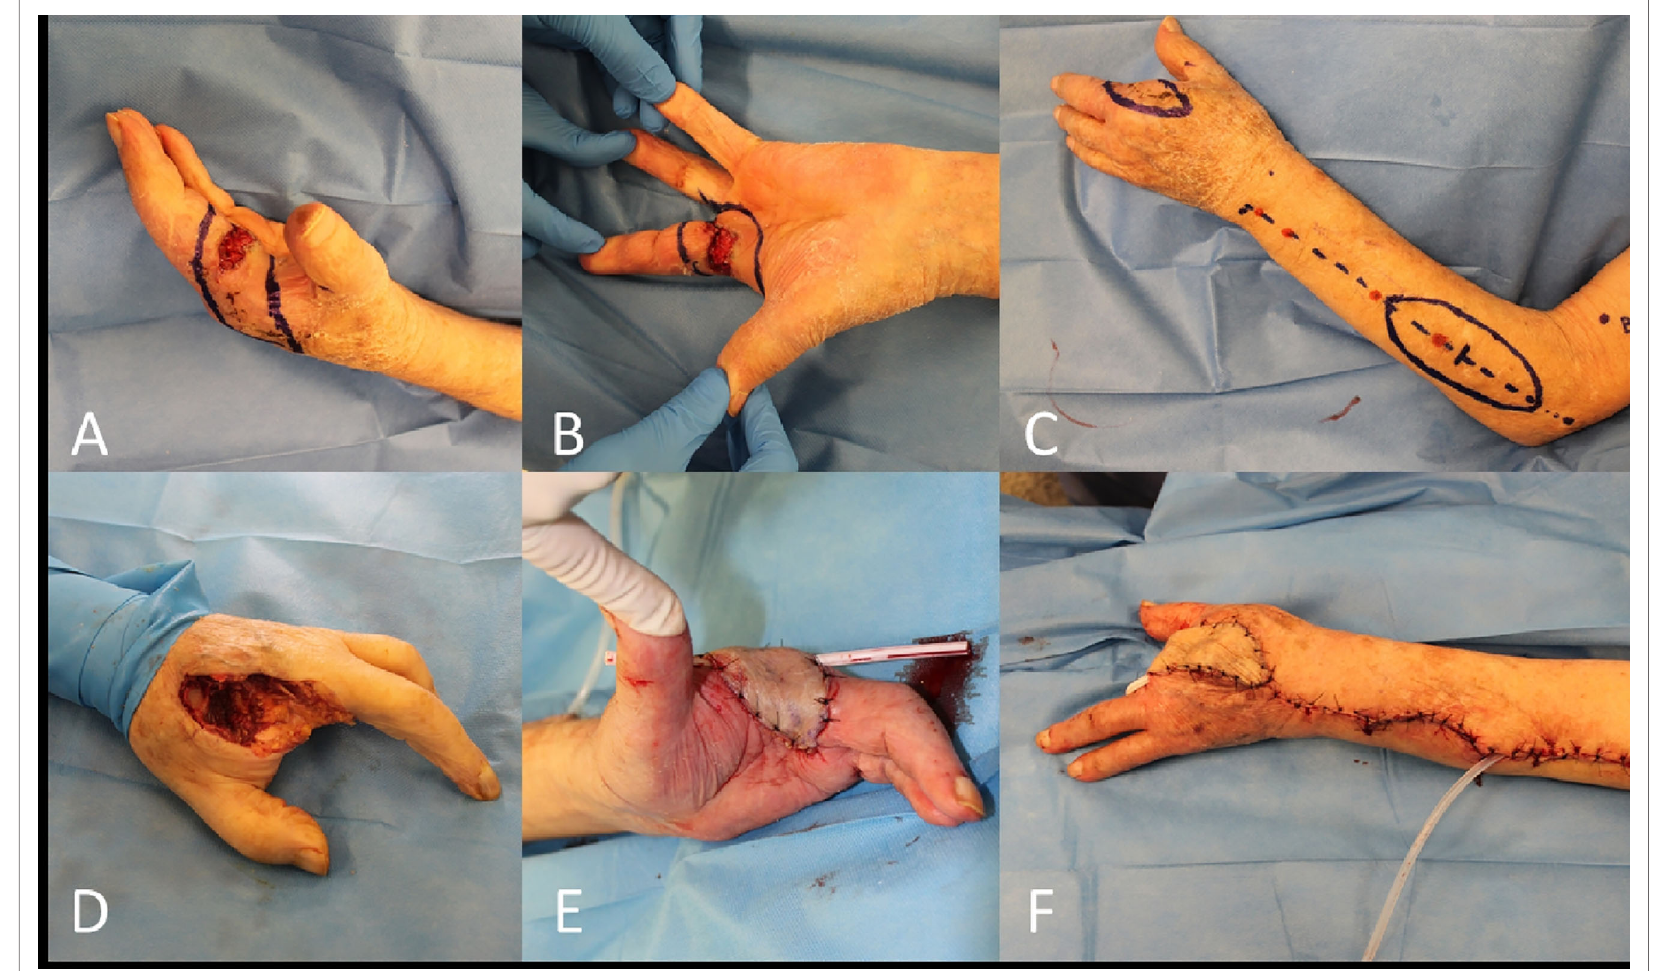
FIGURE 12 | (A, B) Recurrent and locally advanced cSCC of the base of the long fi nger (second amputated previously); (C) Posterior interosseous fascial fl ap planned; (D) End of the third hand ray amputation; (E, F) Final result after rotation of the fl